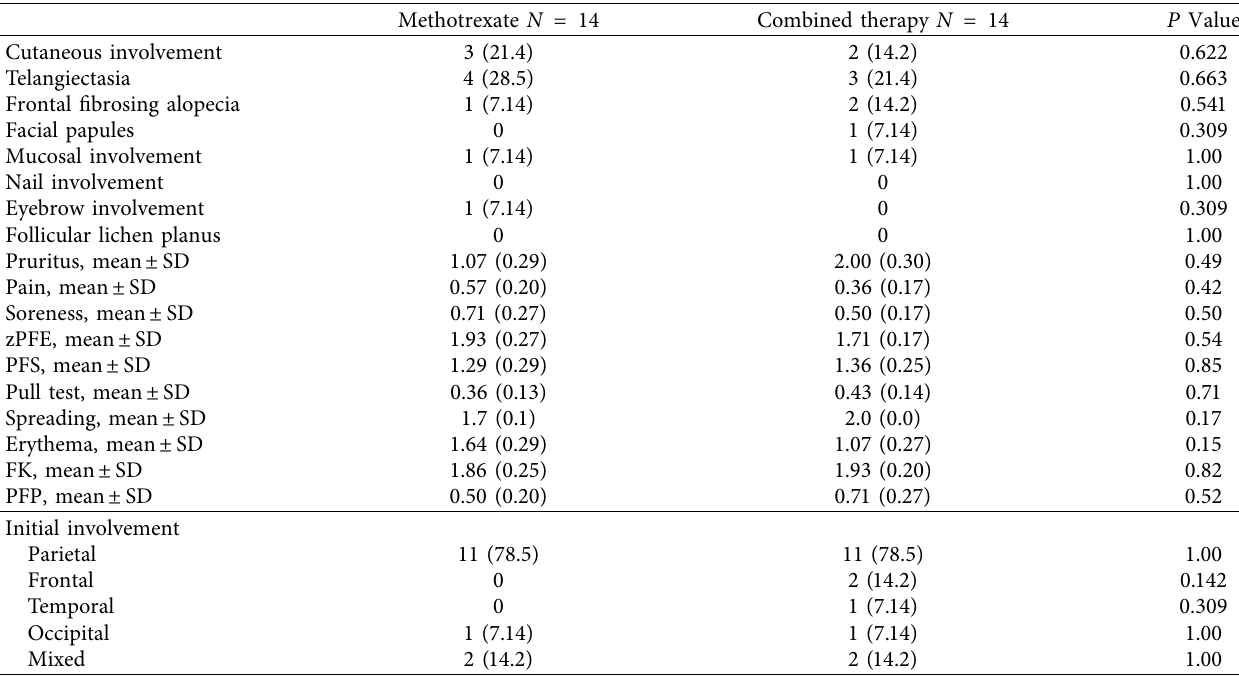
Table 2: Categorical background characteristics of participants by intervention groups.